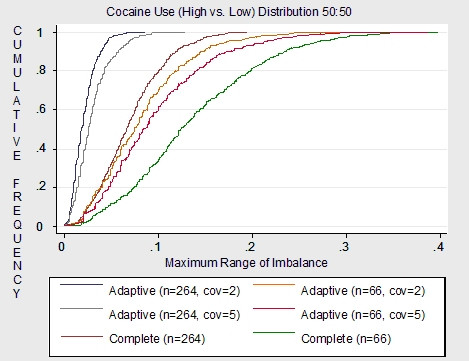
Complete and adaptive randomization: cocaine covariate imbalance (treatments = 3 simulations = 1000).